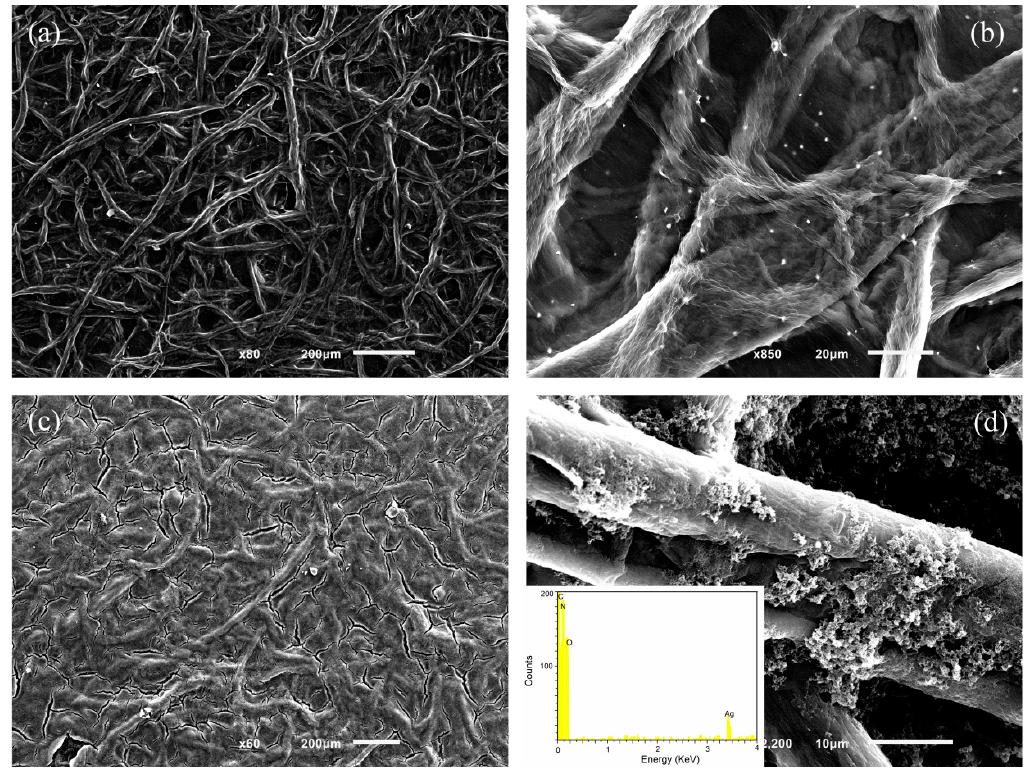
Figure 3. ( a , b ) SEM images of the rGO/Ag/FP composite; ( c , d ) SEM images of the PANI/rGO/Ag/FP